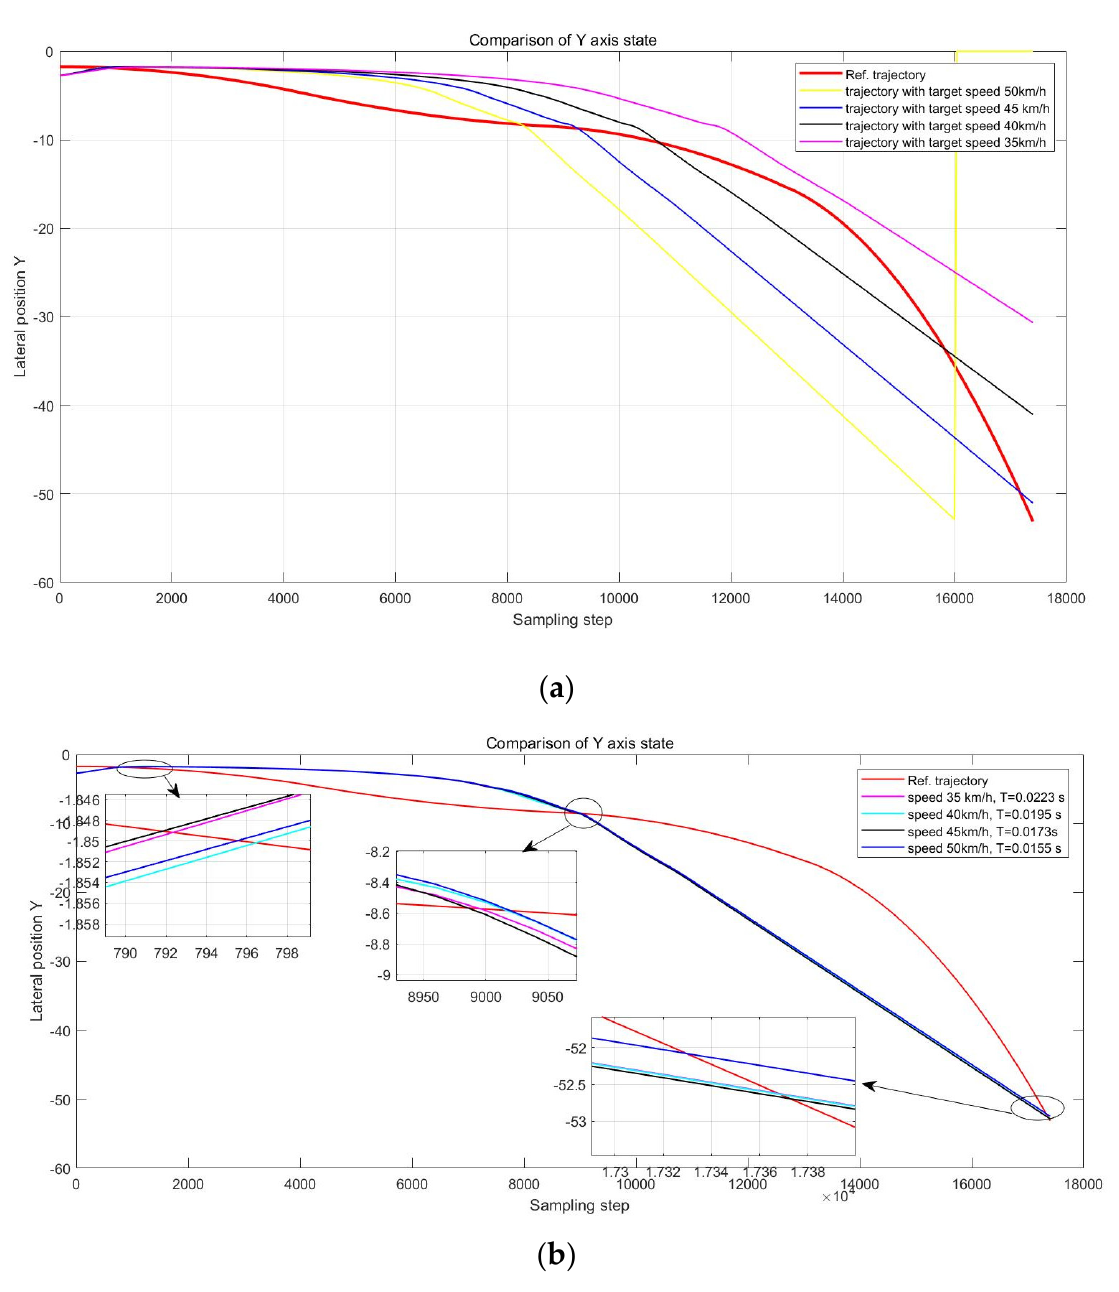
Figure 8. ( a ) Shows the tracking difference with the reference path after changing the target speed. ( b ) Shows the tracking difference with reference path after changing the target speed and the sample time T tuning condition.